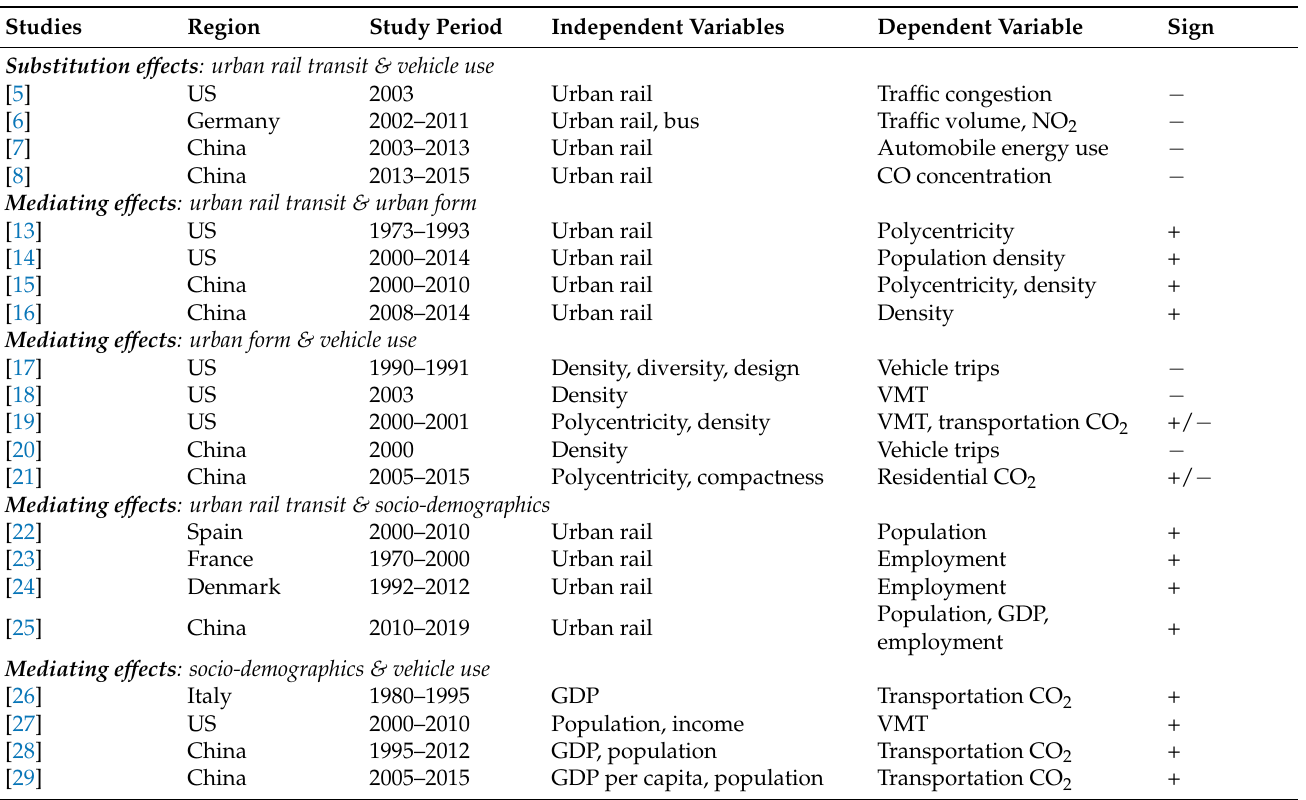
Table 1. Literature on vehicle use effects of urban rail